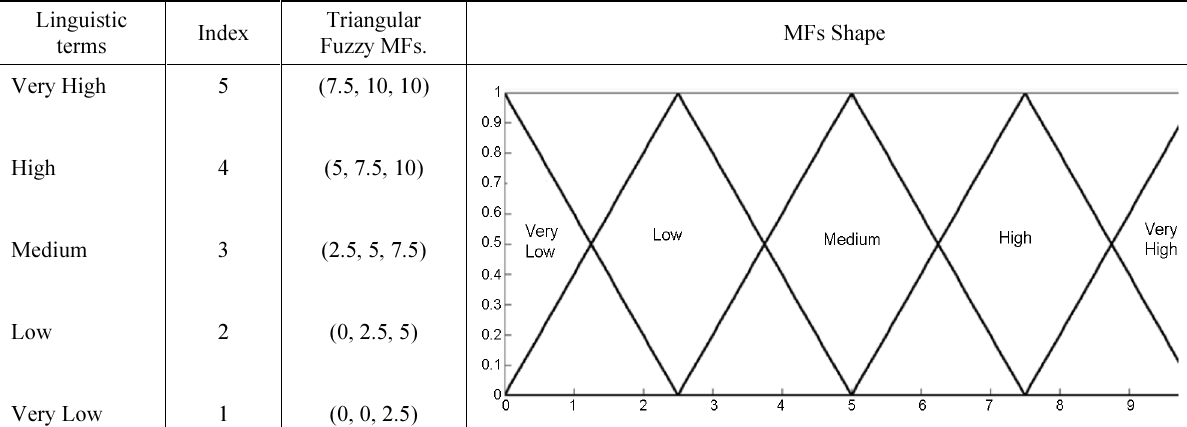
Table 1. Linguistic